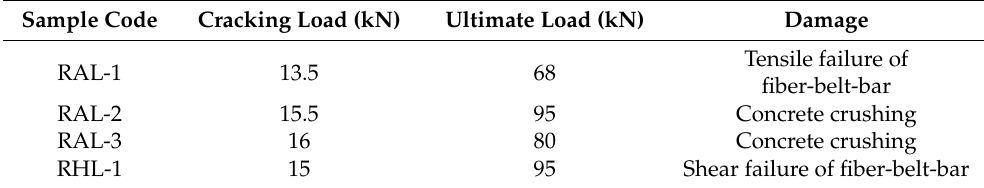
Table 5. The cracking, ultimate load and failure of test